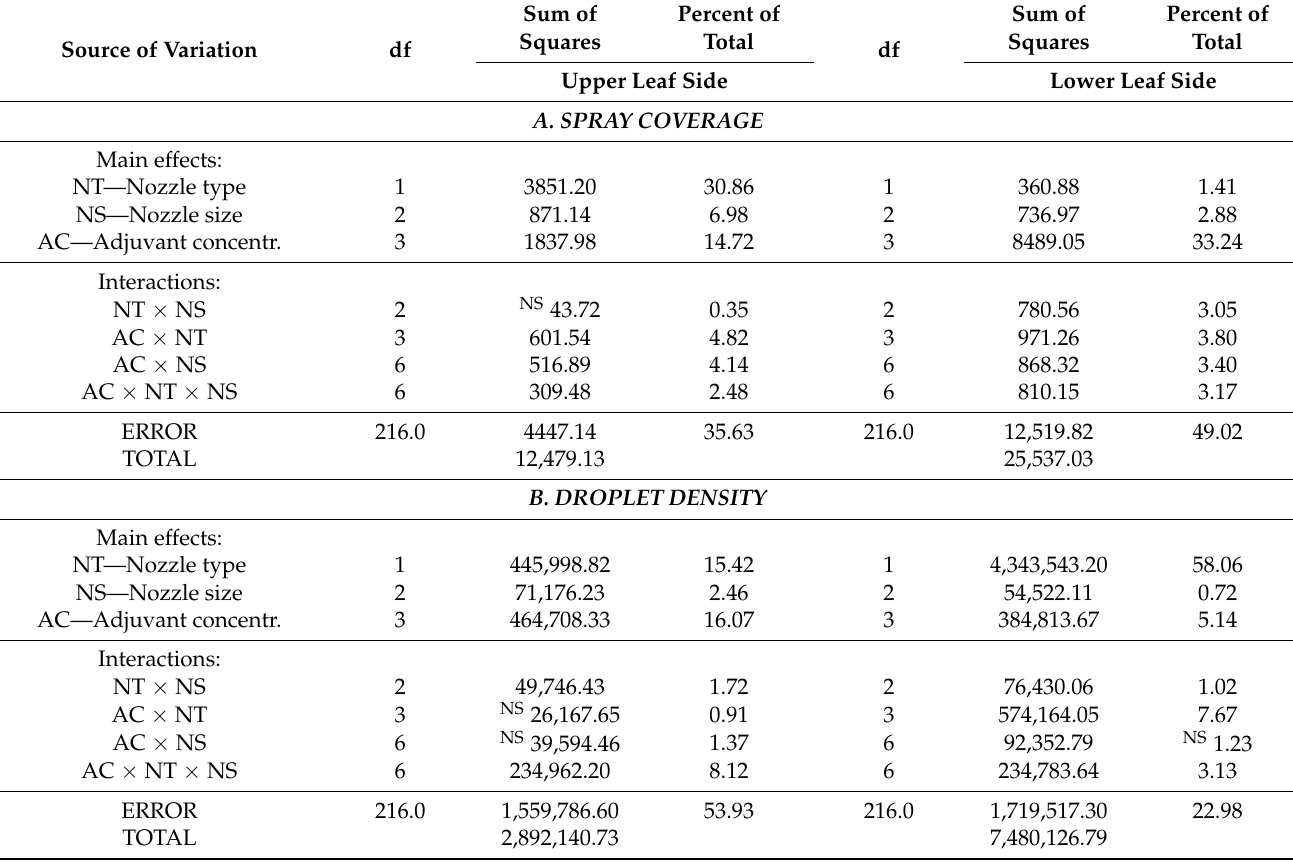
Table 3. The ANOVA summary table for data sets of spray coverage (A) and droplet density (B) on upper and lower surfaces of apple leaves obtained during the treatments with adjuvant Agral 90. The denotation NS indicates not significant effects or interactions at p < 0.05.